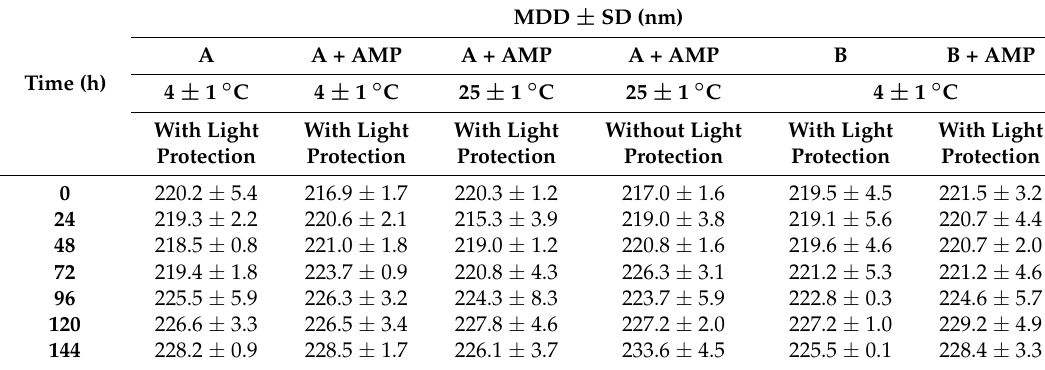
Table 2. MDD of lipid emulsion in studied TPN admixtures during storage. Results are shown as the mean values of three samples ±